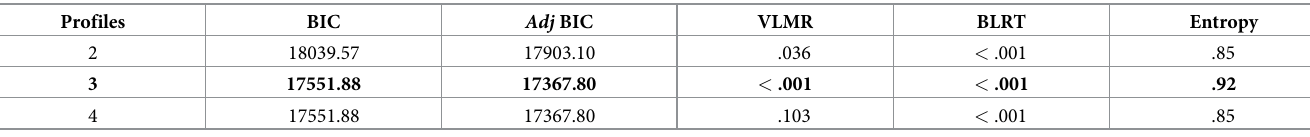
Table 3. Model fit indices for 2- through 4-profile solutions for beef farmers. Profiles